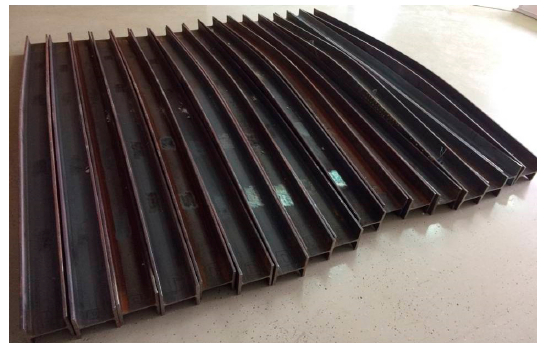
Figure 8. Post ‐ test column specimens. Figure 8. Post-test column